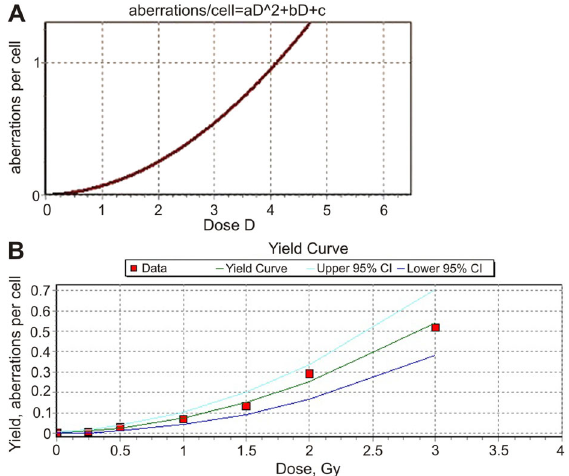
Figure 1. Dose-response calibration curve for dicentric yields induced by irradiation with LINAC X-rays. Data fi tted with CABAS ( A ) and Dose Estimate ( B ) Table 3. Comparison of linear and quadratic yield coef fi cients and goodness-of- fi t parameters calculated with the CABAS and the Dose Estimate programs. Program